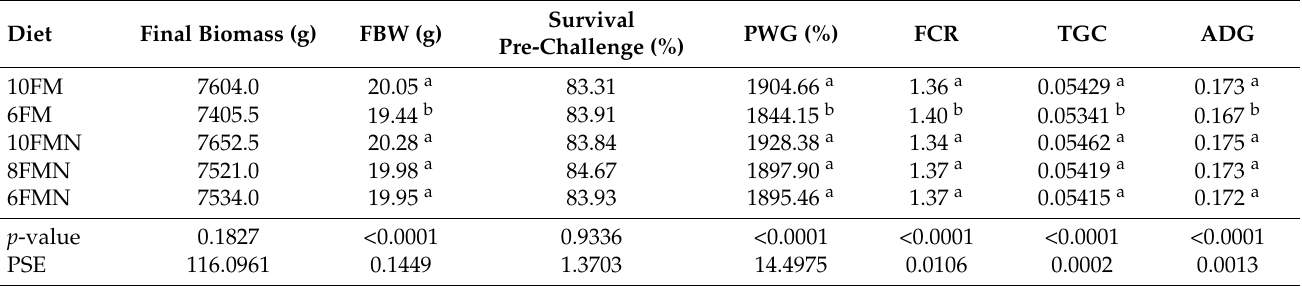
Table 3. Growth performance of Pacific white shrimp (PWS) fed diets supplemented with nucleotides (N) and different levels of replacement of fish meal (FM) by vegetable protein sources for 110 days. Values represent the mean of ten replicates. Results in the same columns with different superscript letter are significantly different ( p <